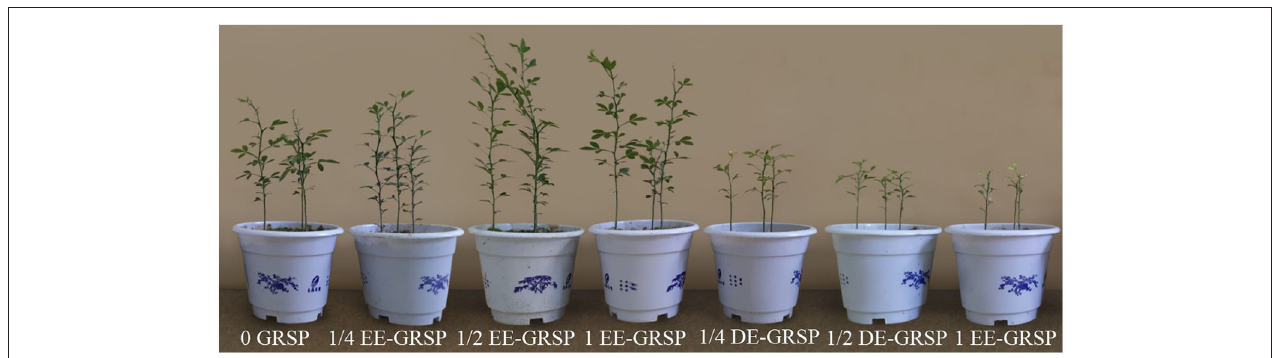
FIGURE 1 | Growth performance of trifoliate orange by exogenous EE-GRSP and DE-GRSP at varying strength. DE-GRSP, difficultly extractable glomalin-related soil protein; EE-GRSP, easily extractable glomalin-related soil